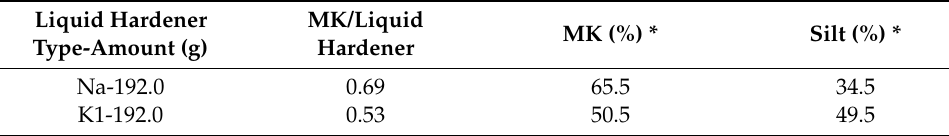
Table 3. Detailed mixture design for geopolymer cement